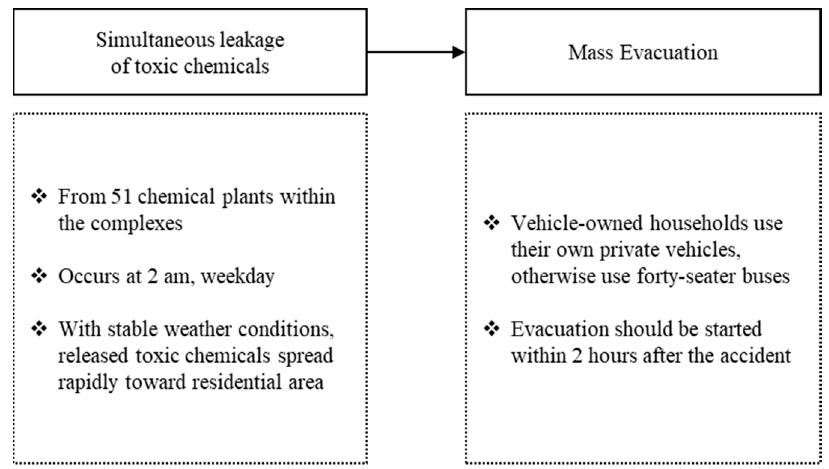
Figure 2. Baseline scenario of chemical accident and mass evacuation.